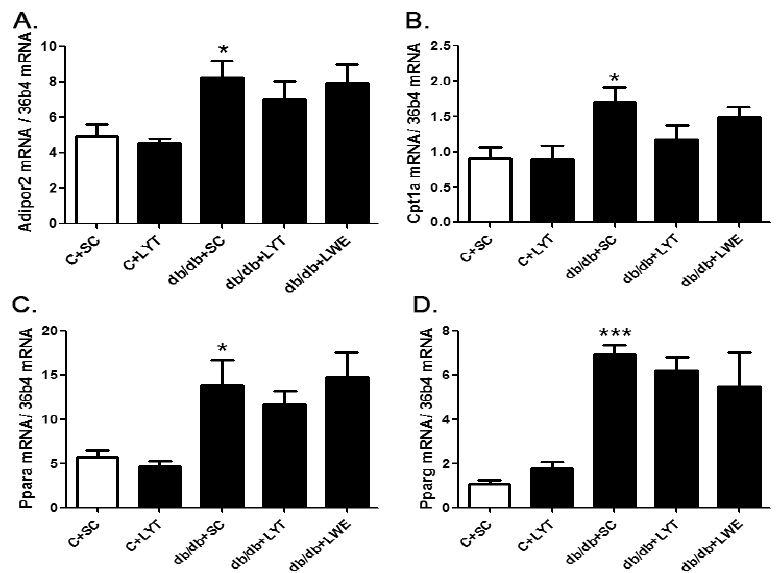
Figure 7. The mRNA expression of genes involved in lipolysis in the liver of control and db/db mice at age of 20 weeks. Adipor2 ( A ); Cpt1a ( B ); Ppar α ( C ); and Ppar γ ( D ). Values are means ± SE ( n = 4–6). * p < 0.05; *** p < 0.001 when compared with the C + SC group.